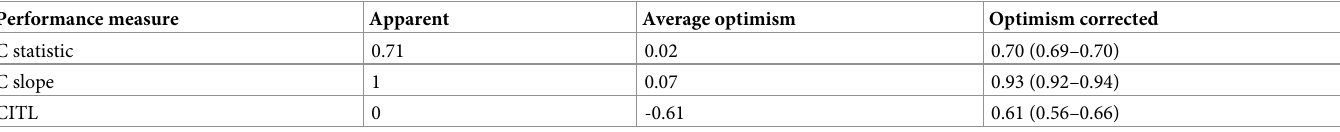
Table 3. Apparent and internal validation performance statistics of the final prediction model (with 95% CI) including C statistic, Calibration slope and Calibra- tion-in-the-large. Performance